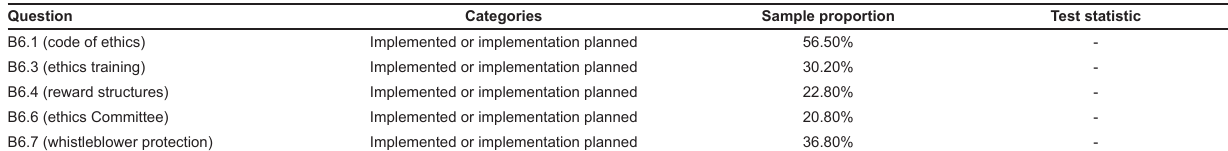
TABLE 6 Degree of ethical intervention adoption